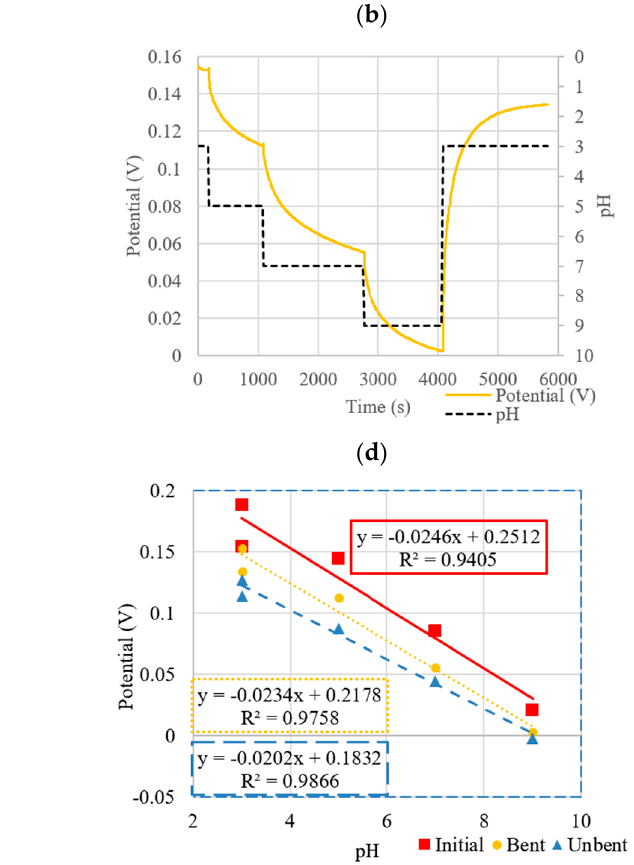
Figure 15. Sensitivity curves of PANI-ES composite in initial, bent, and unbent states.